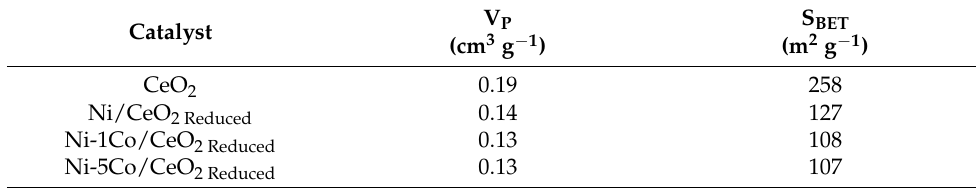
Figure 2. CO 2 -TPD profiles for reduced catalysts with different Co content. Table 3. Porous volume and external surface area for studied Table 2. Comparison of basicity of the samples in present study.